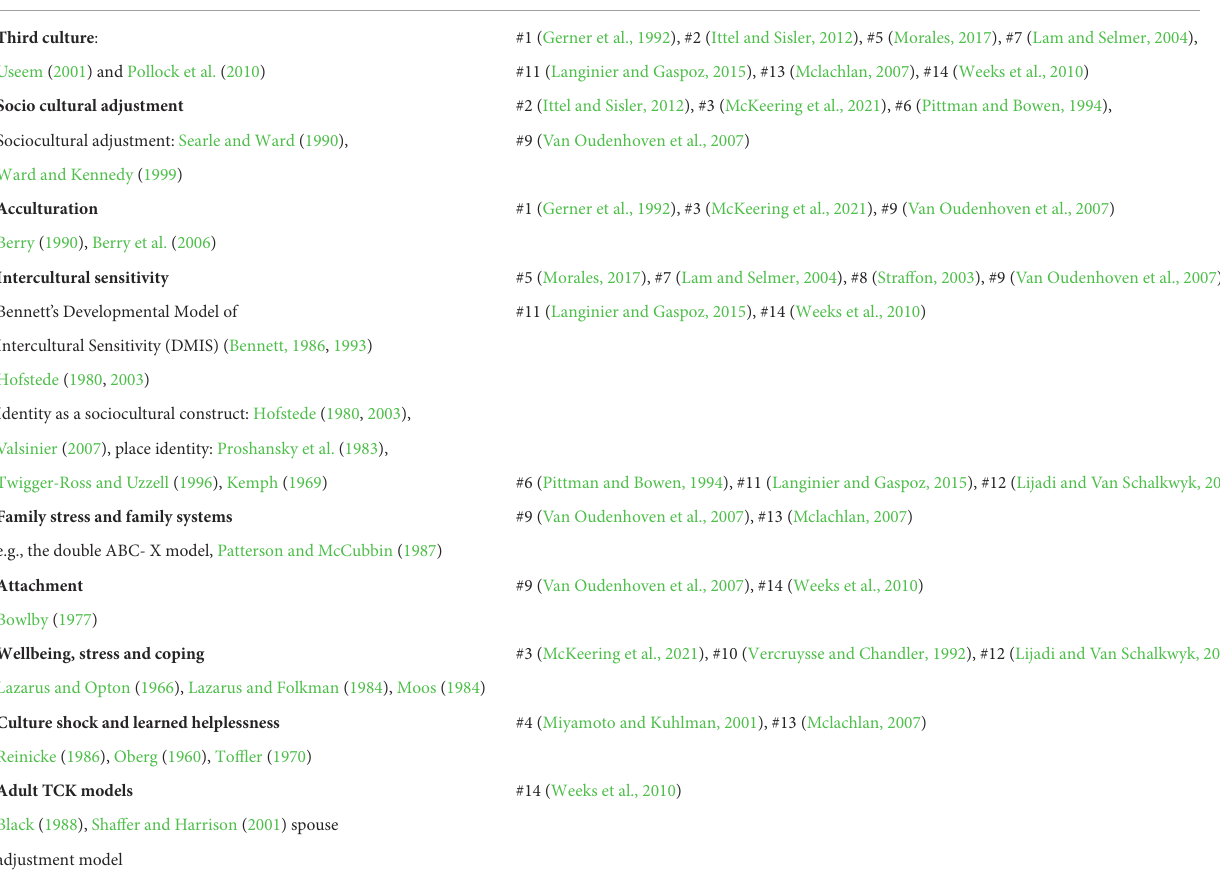
TABLE 1 Theories stated in extracted